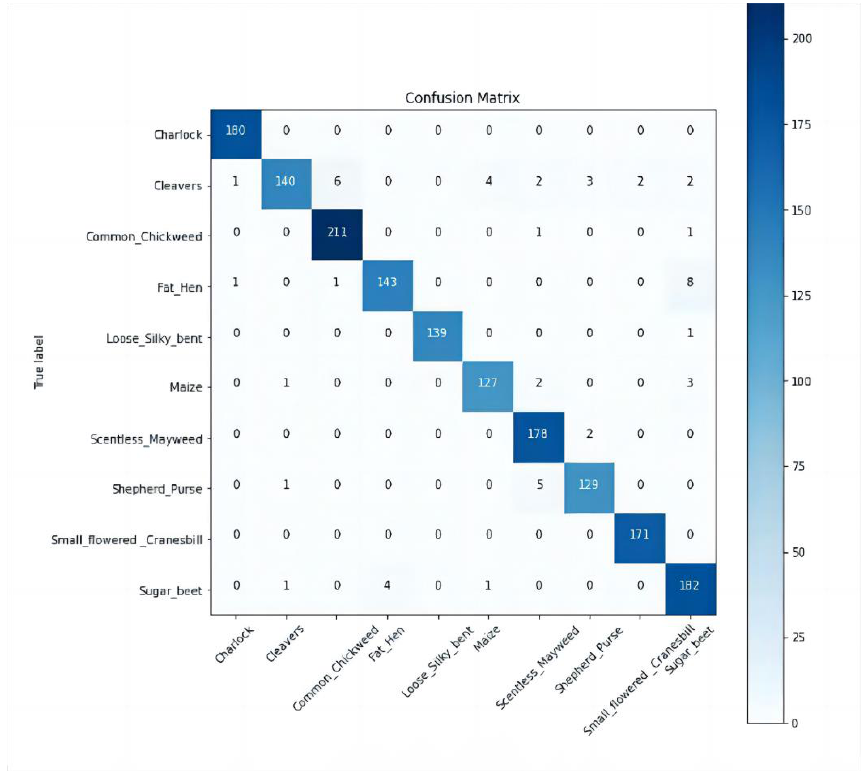
Figure 13. Confusion matrix diagram of identification results.